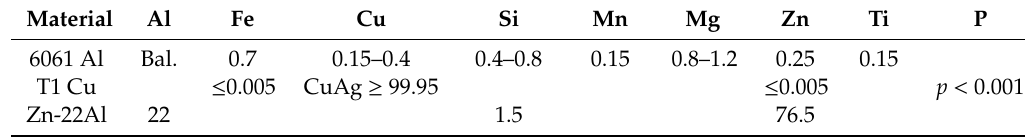
Table 1. Chemical compositions of 6061 Al alloy, T1 Cu alloy, and Zn–22Al alloy.